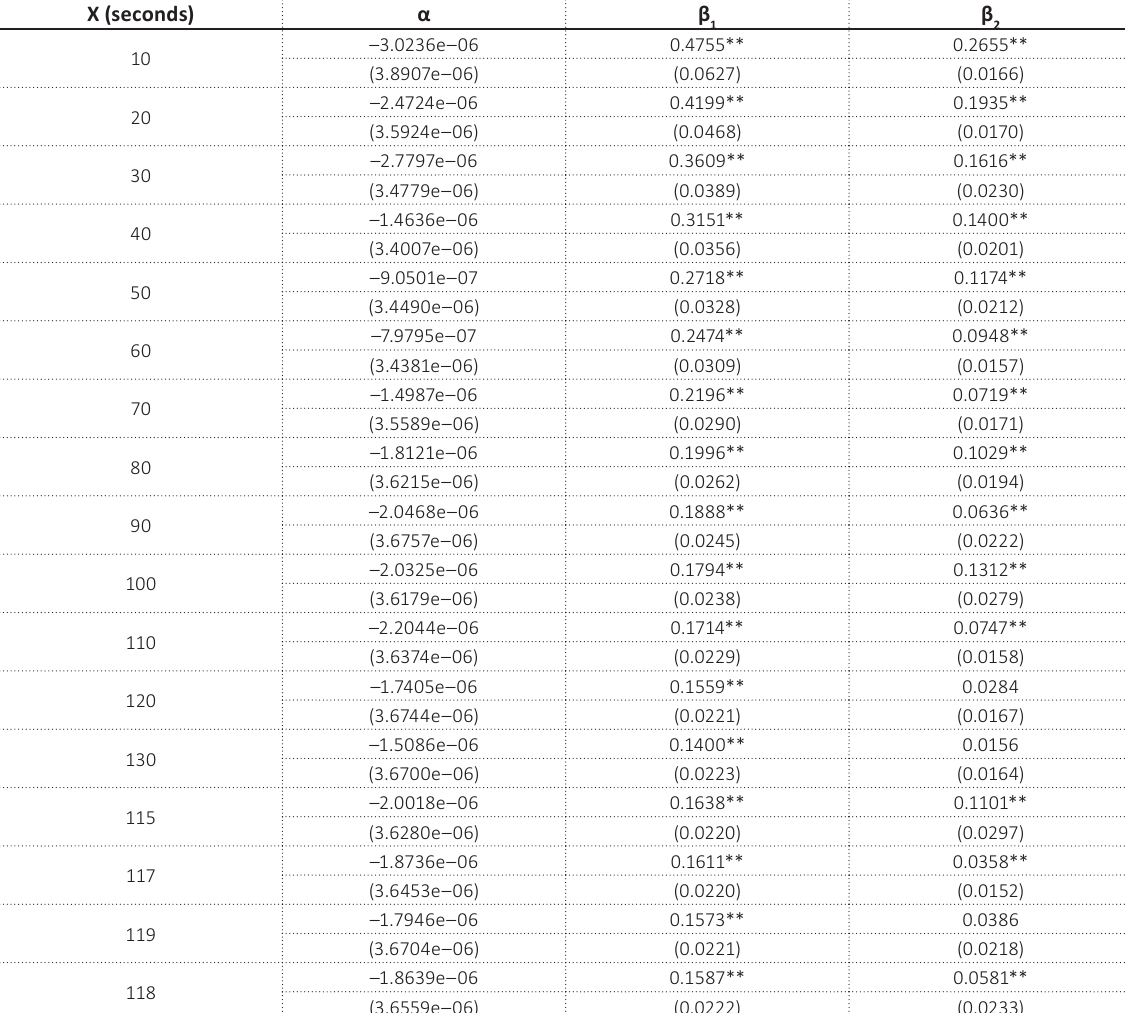
Table 1. Estimation steps for the lead time of Bitcoin over Cardano, for January